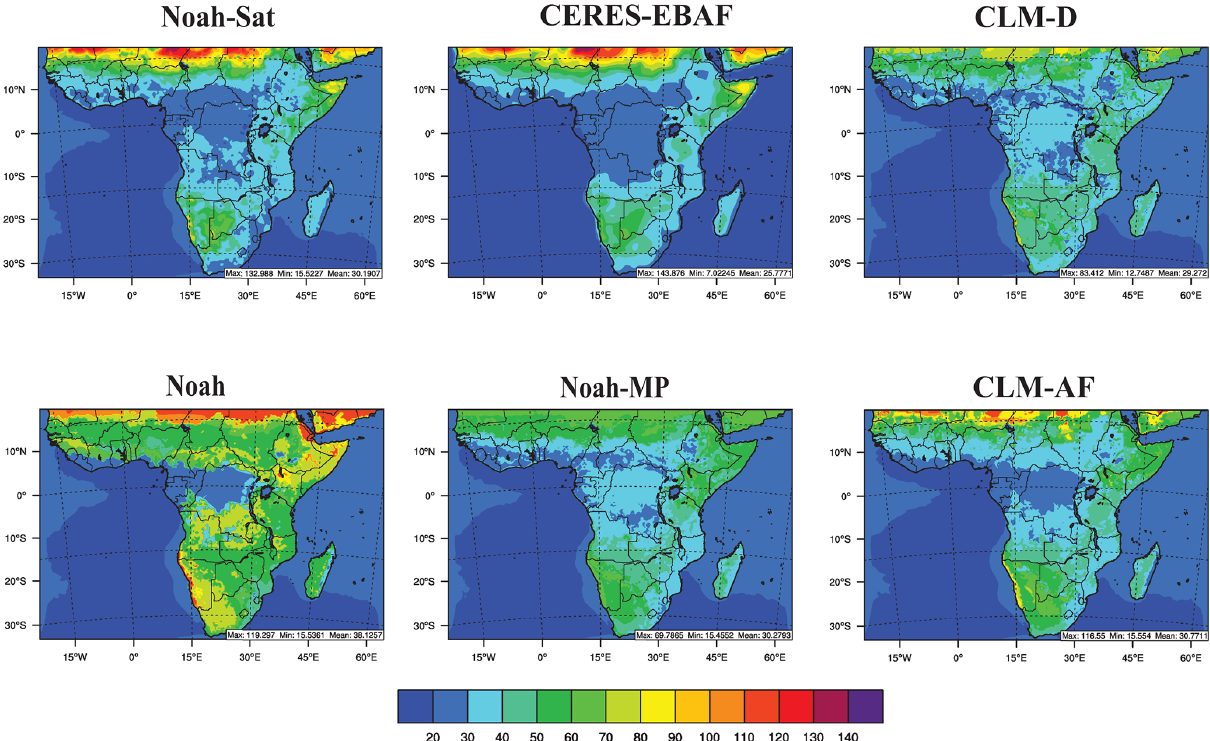
Figure 7. Year 2013 annual average upwelling shortwave radiation at the Earth’s surface (Wm − 2 ) for CERES-EBAF estimates and WRF